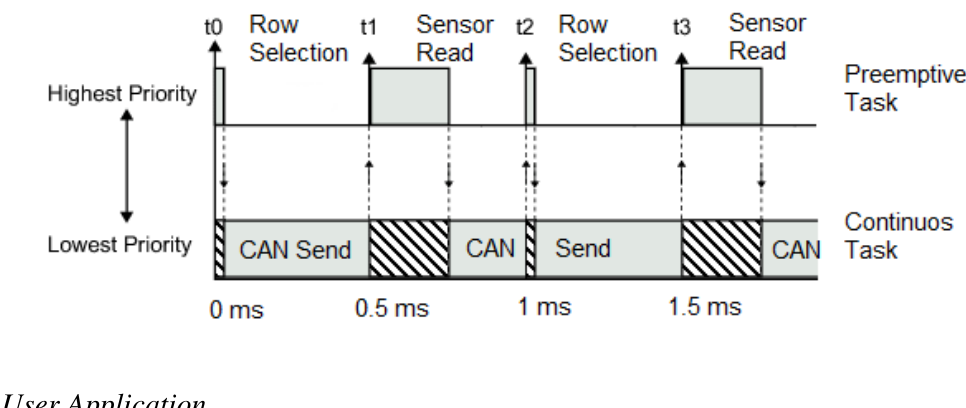
Figure 8. The idle task block enables a real-time multitasking environment without needing a real-time operating system; this figure shows the tasks execution over